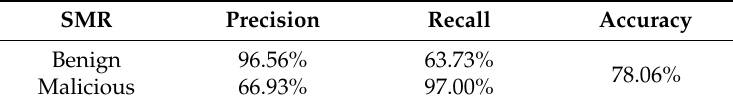
Table 6. Performance of soft-max regression (SMR).